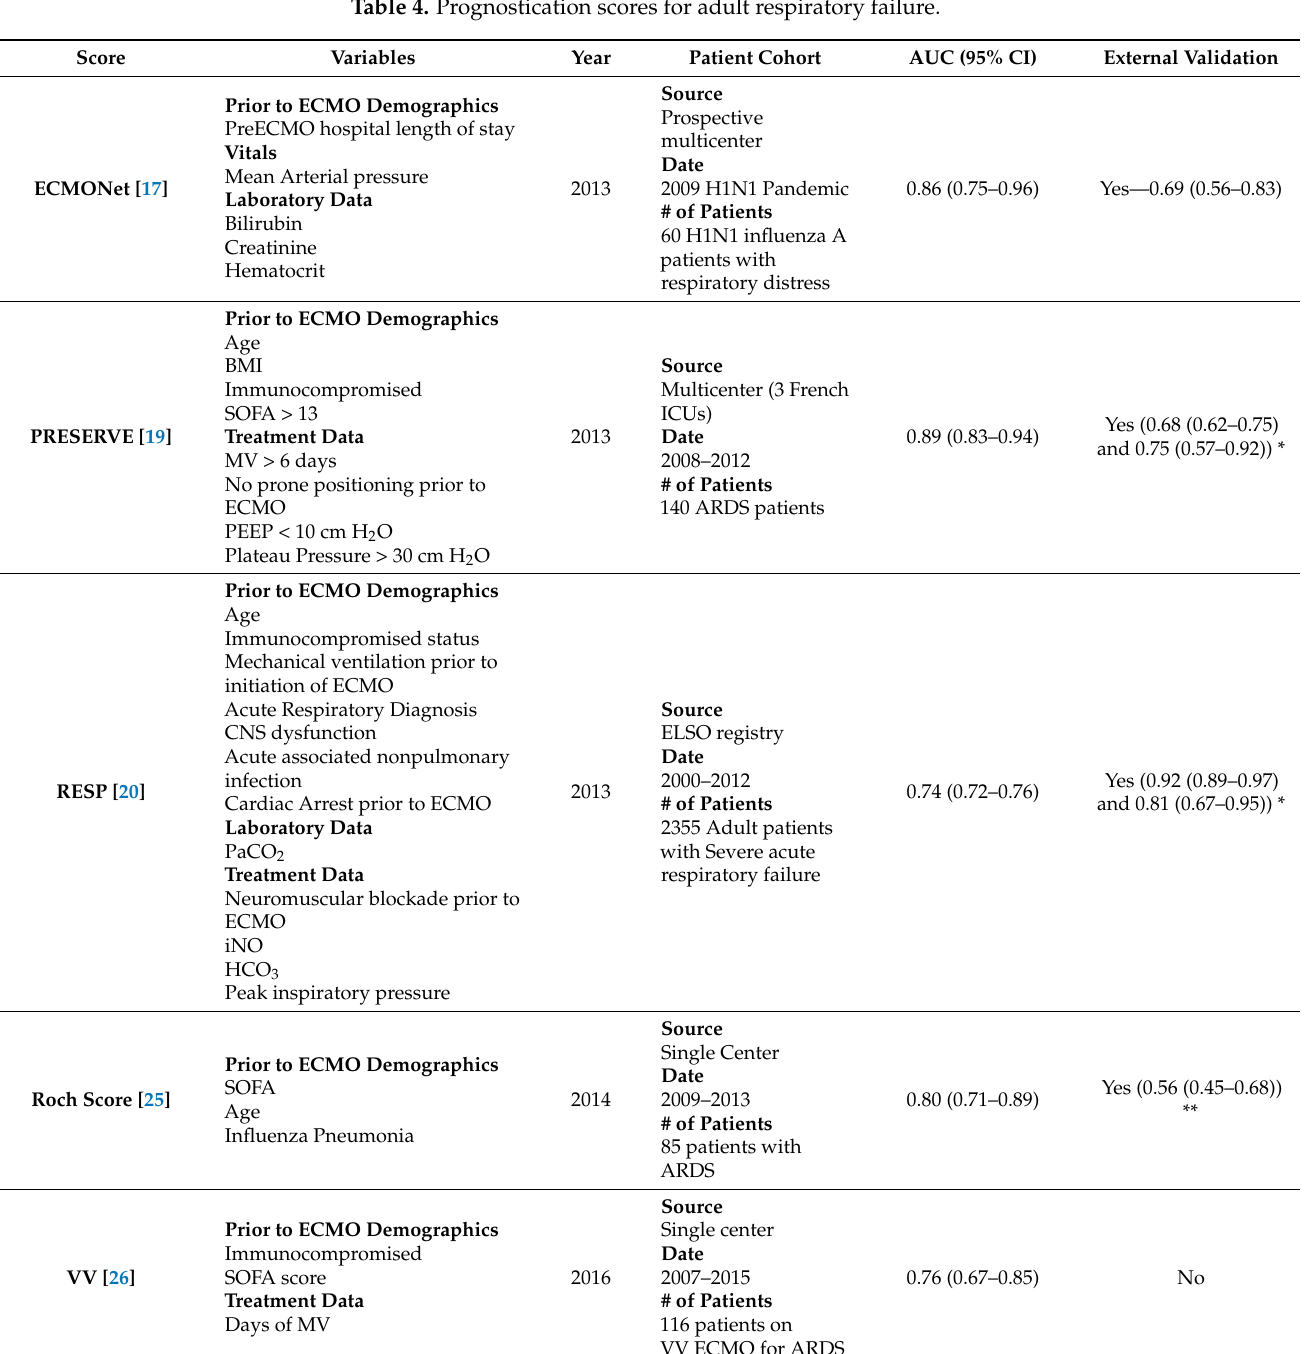
Table 4. Prognostication scores for adult respiratory